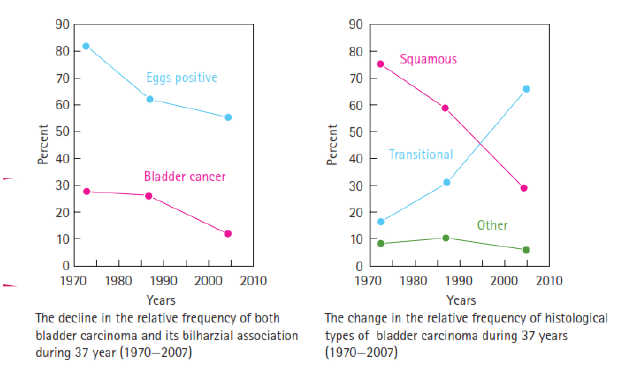
Figure 1 : Relative frequency of bladder cancer and bilharziasis in Egypt over a 37 years period. Courtesy of the Journal of the National Cancer Institute